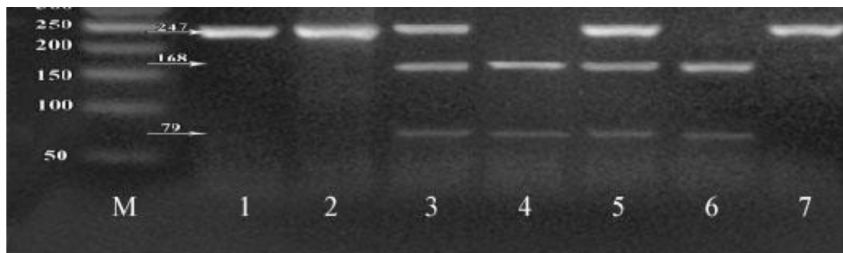
Figure 2. 3% agarose gel for c.1517G > C digested product: 50 bp DNA ladder in lane M, lanes 1, 2, 7: contain one 247 bp band of G/G genotype, lanes 4, 6: contain 168, 79 bp bands represent C/C genotype. Lanes 3, 5: contain 247, 168, 79 bp bands represent the G/C